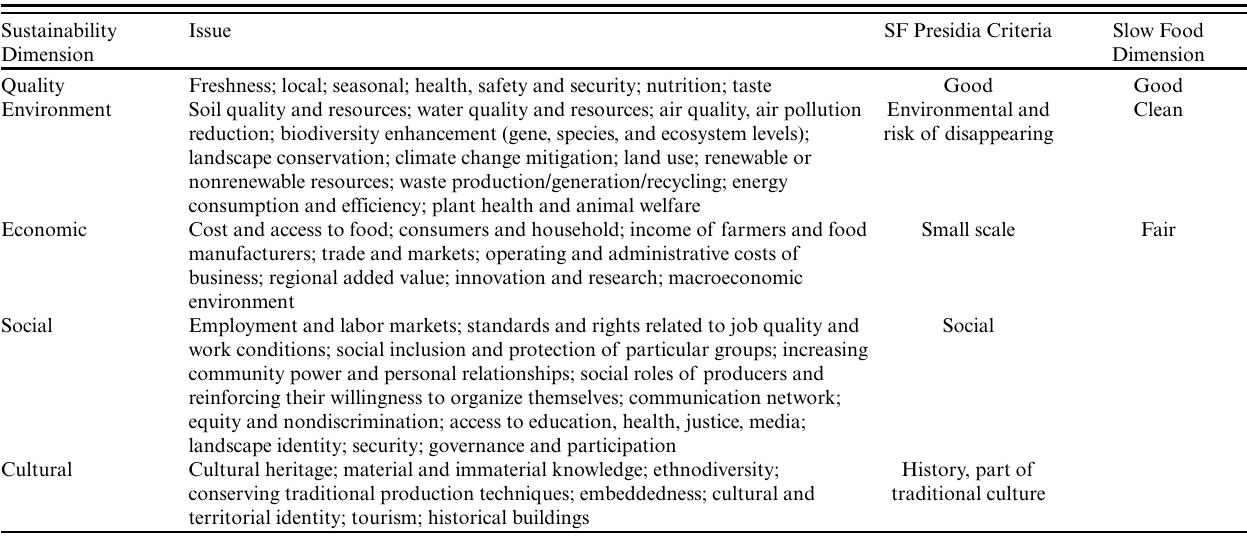
Table 1 . List of quality, environmental, social, economic, and cultural impact issues used previously to assess the sustainability of agro- food systems, with reference to the Slow Food criteria of good, clean, and